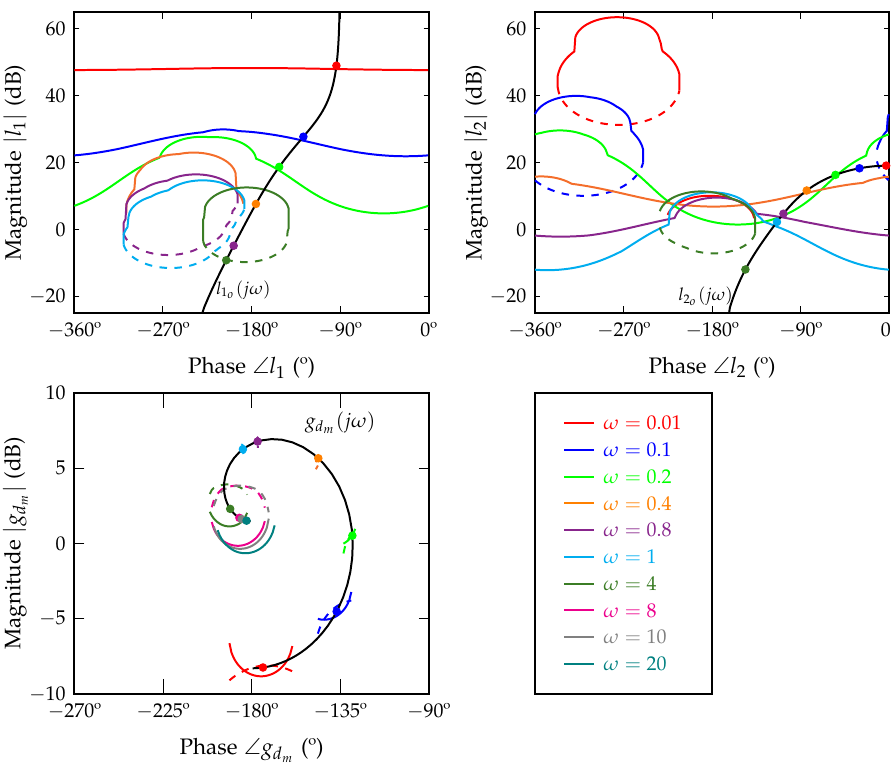
Figure 4. Bounds and loop-shaping for (north west) c 1 , (north east) c 2 , and (south west) g d